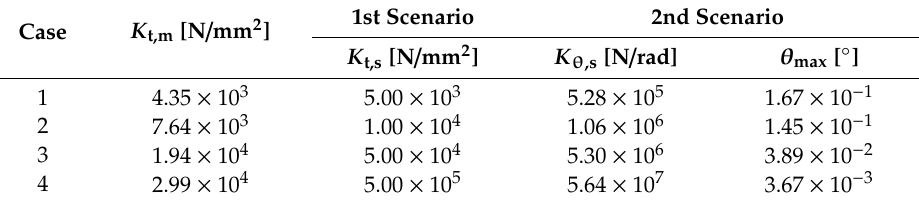
Table 3. Summary of the four cases analysed in first and second scenario using a cyl.-to-flat contact configuration.